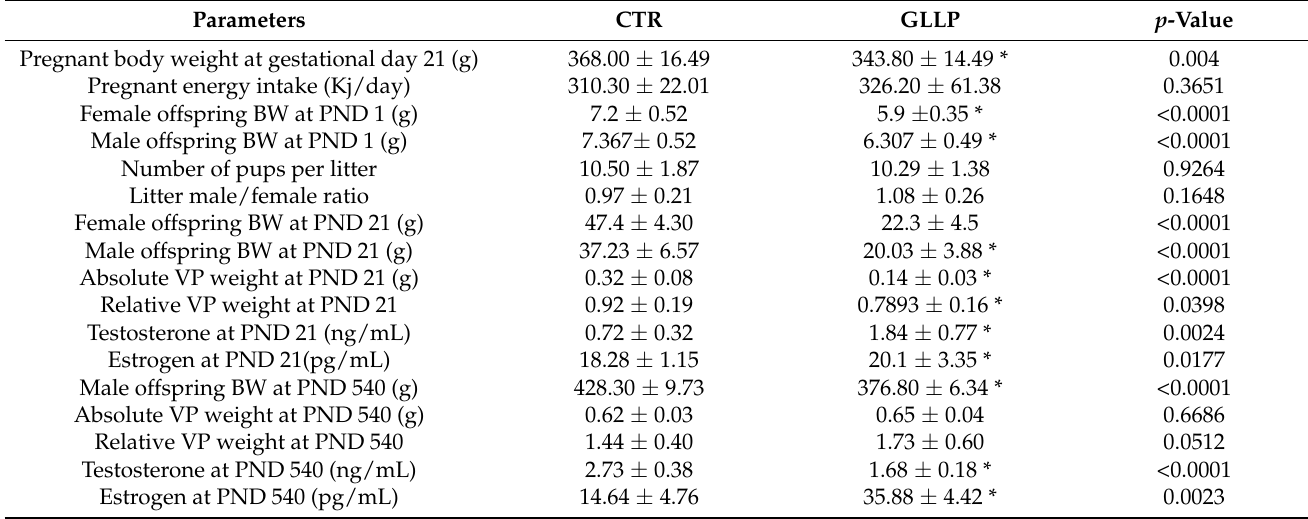
Table 1. Biometric and metabolic parameters of pregnant and offspring rats from the CTR and GLLP groups.